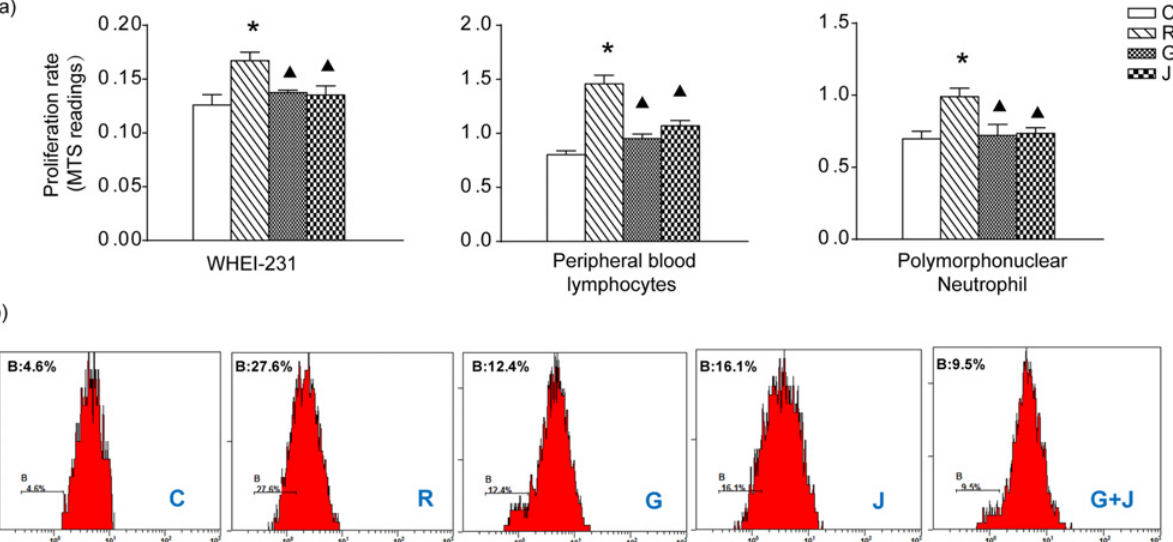
Fig 4. Effect of JP on the proliferation of cells. (a) The proliferation of YAC-1 cells, rat peripheral blood lymphocytes and polymorphonuclear neutrophils determined by MTS. The absorbance was subsequently measured at 490 nm using an automatic microplate reader. (b) The proliferation of rat spleen lymphocytes determined by CFSE method. The proliferation dynamics of CFSE labeled cells were analyzed by flow cytometry within 1 hour. The B region of the cells was showed as group of proliferation cells. * p < 0.05 compared with the C group, ▲ p < 0.05 compared with the R group.